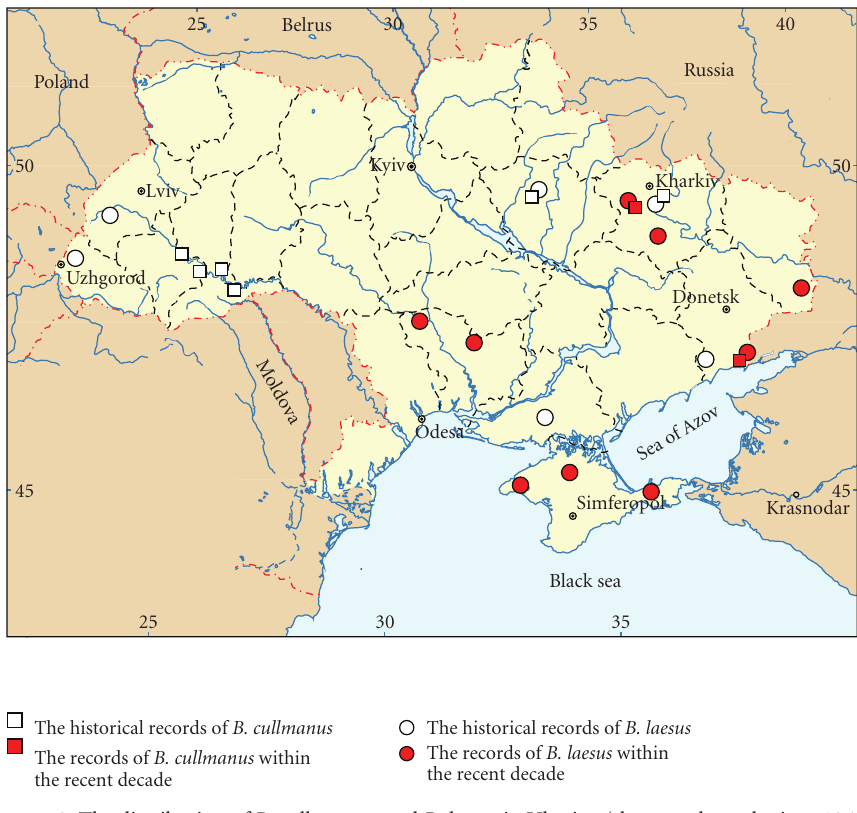
Figure 3: The distribution of B. cullumanus and B. laesus in Ukraine (the records made since 1868).